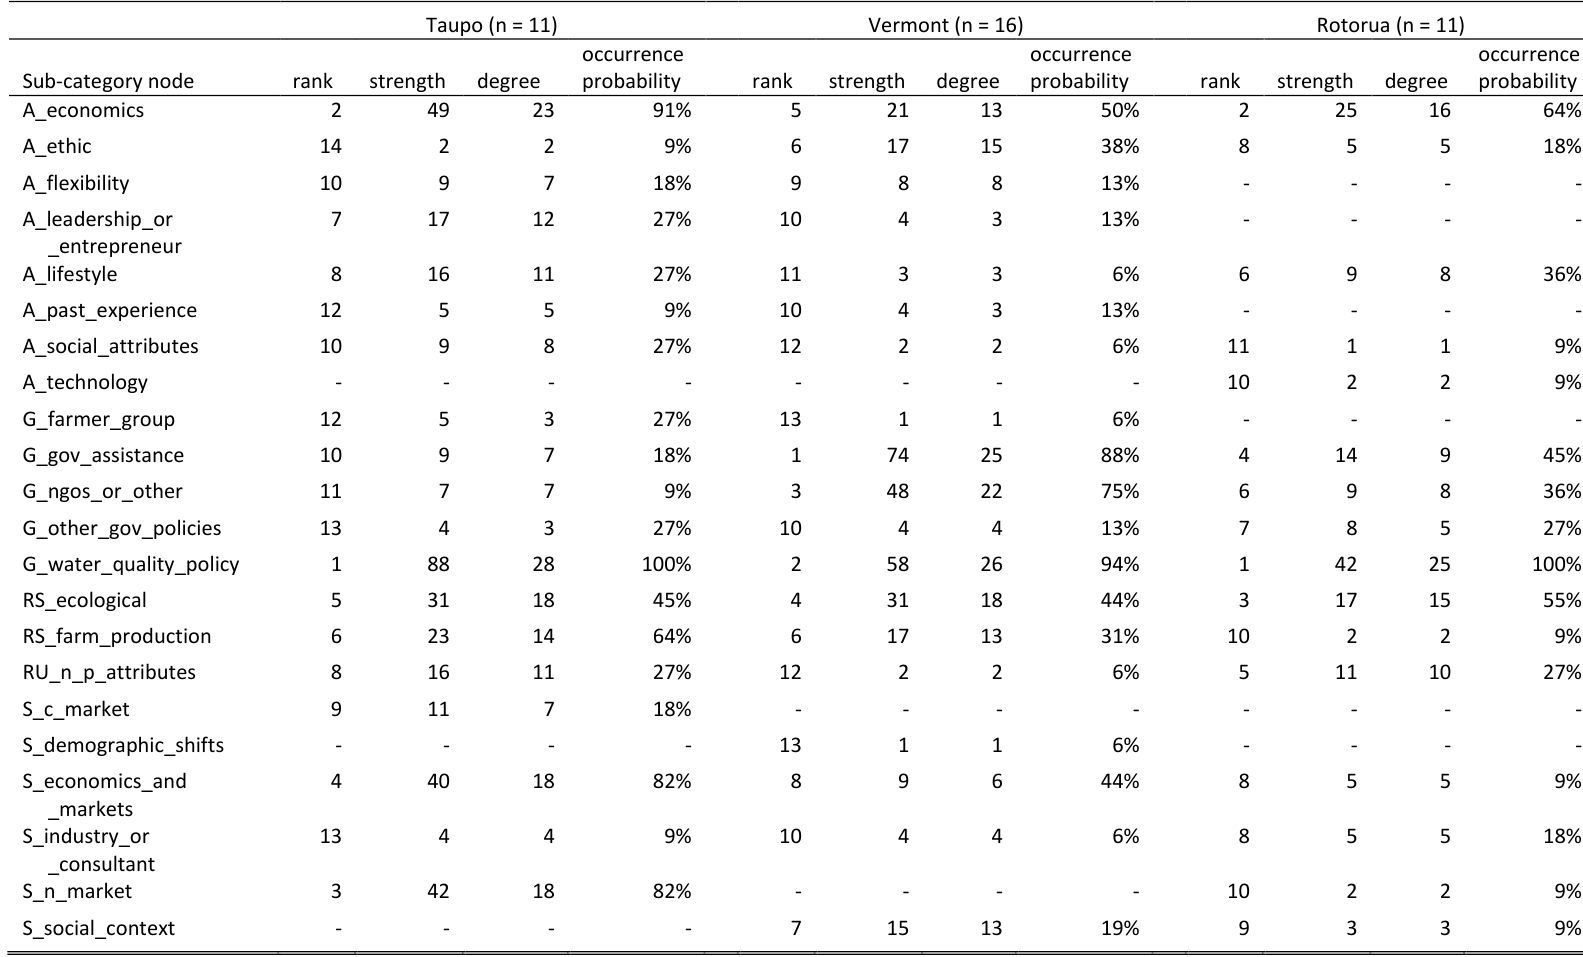
Table A1.3 . Driver node statistics by region in Driver-behavior sub-network. Rank reflects the descending rank of strength (high to low). The data driving these ranks is from the Driver-behavior sub-network so ranks do not reflect influence on